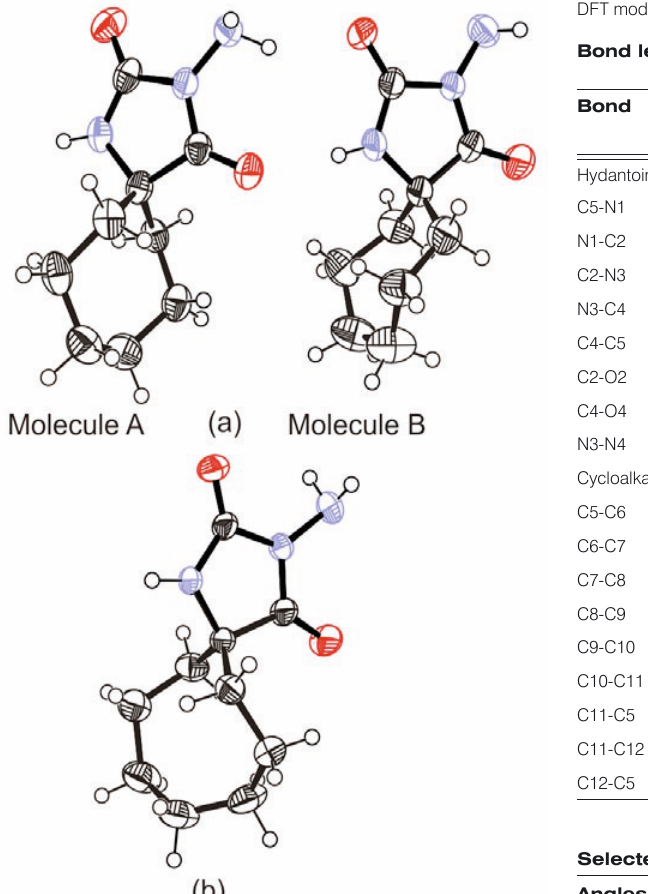
The cyclooctane ring in (II) adopts a boat-chair (BC) conformation [19] which is consistent with observed conformations in cyclooctanespirohydantoin [15] and cyclooctanespirohydantoindithione [18]. The angle between the mean planes of the cycloalkane (C5/C6/C7/C8/C9/C10/C11/C12) and hydantoin (N1/C2/N3/C4/C5) rings is 74.2(2)º, 85.0(2)º and 62.6(2)º for (IA), (IB) and (II); respectively, the values for (II) are comparable with those in non-amino [15] (59.6º) and thio cyclooctanespirohydantoines [18] (61.1º). The value for (IA) is also comparable to the one observed cycloheptanespirohydantoindithione [18] (72.3º) while